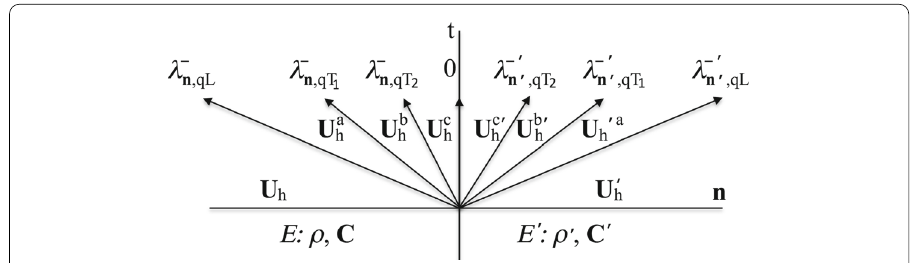
Fig. 1 Sketch illustrating the Rankine–Hugoniot jump conditions in the Riemann problem in the 3D case